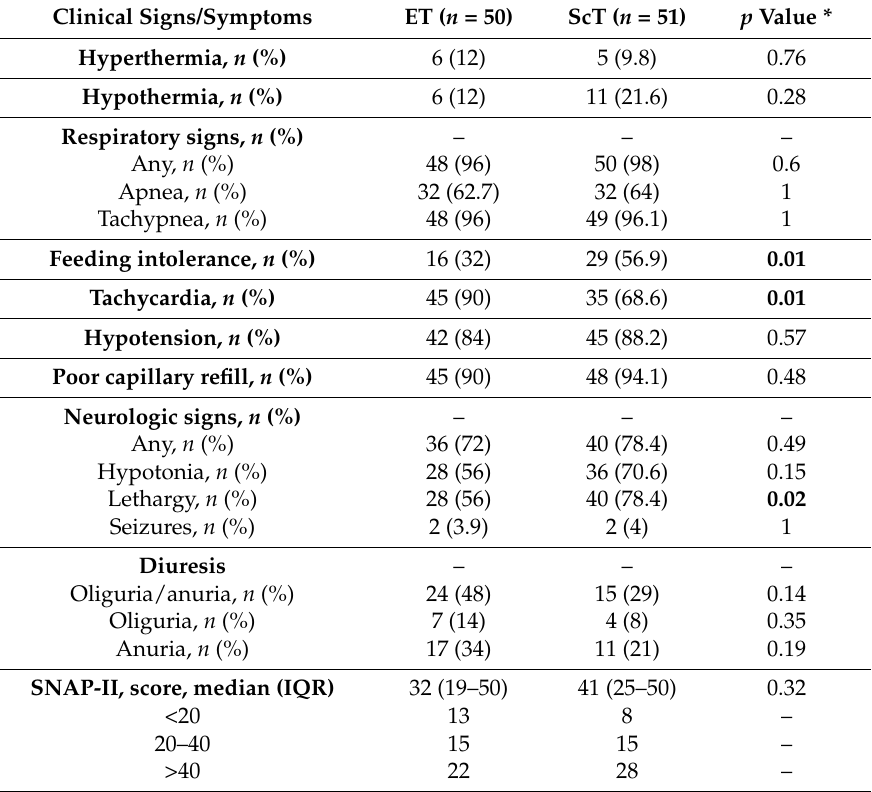
Table 3. Clinical characteristics of the study population at the onset of septic